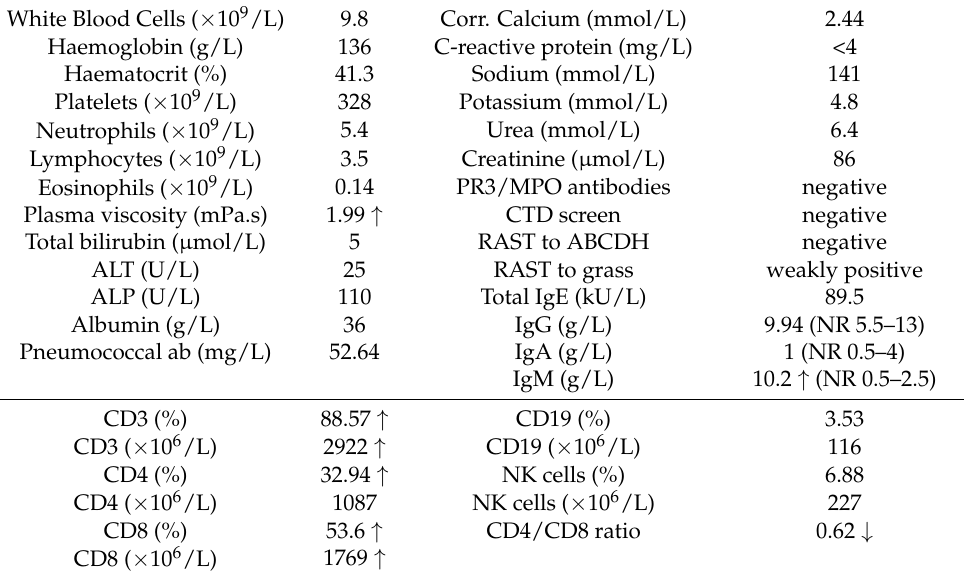
Table 1. Laboratory results and lymphocyte surface marker